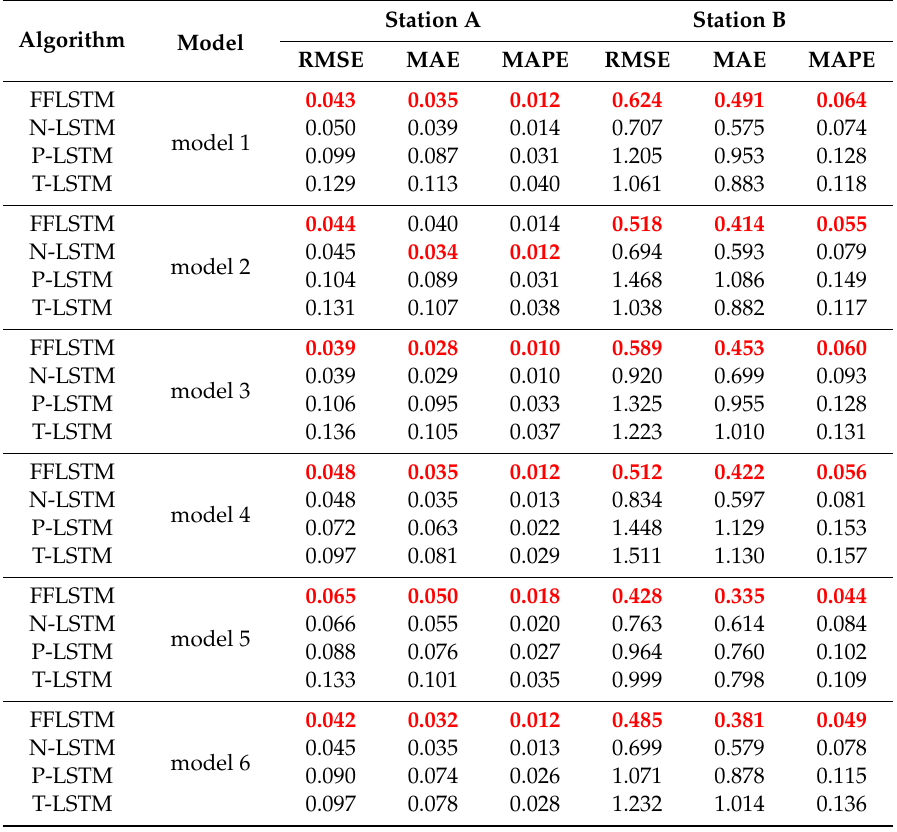
Table 7. The FFLSTM compared with the base short-term memory (LSTM)